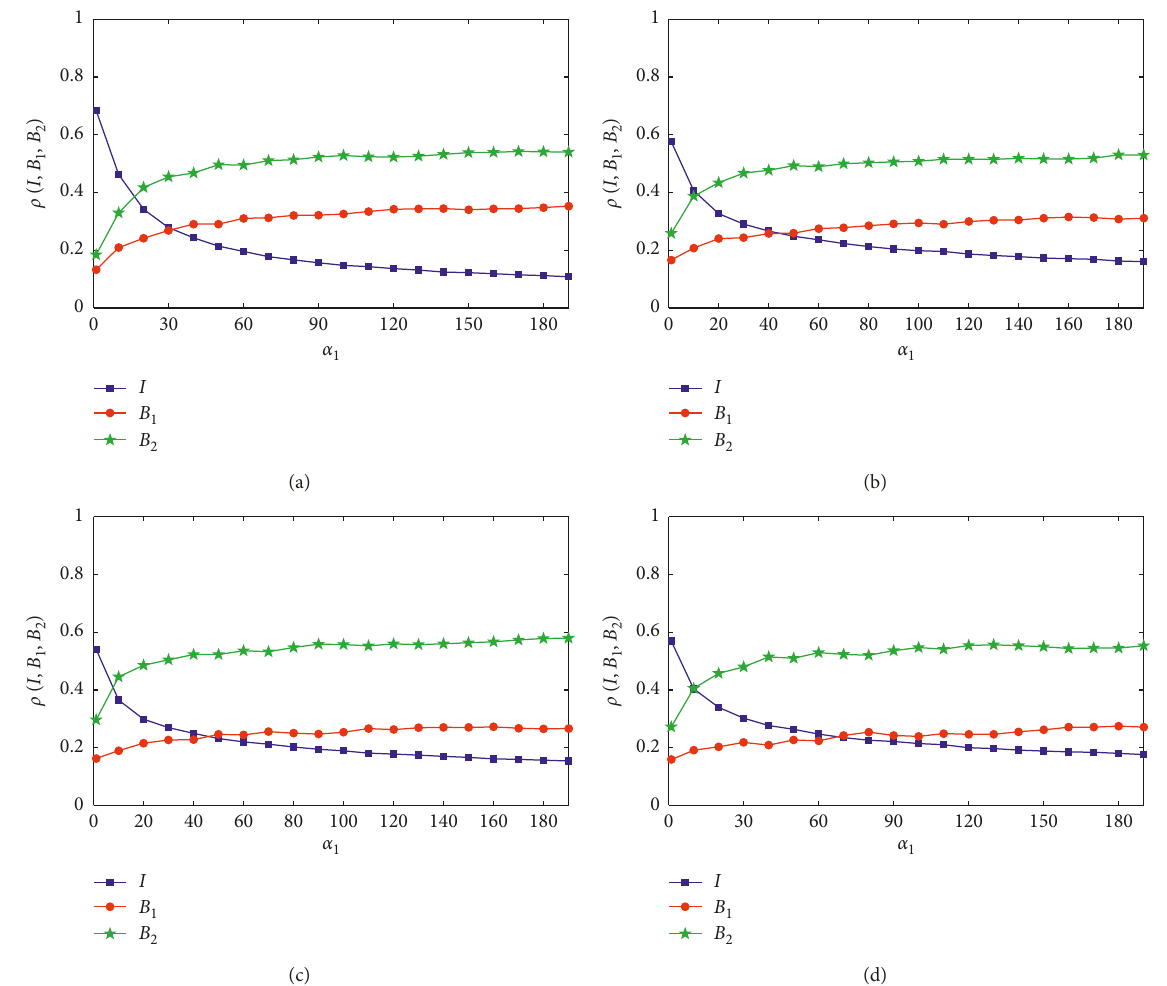
Figure 3: The values of ρ and ε � 0.1. (a) Hamsterster ; (b) Simmons81 ; (c) Oberlin44 ; (d) Bowdoin47